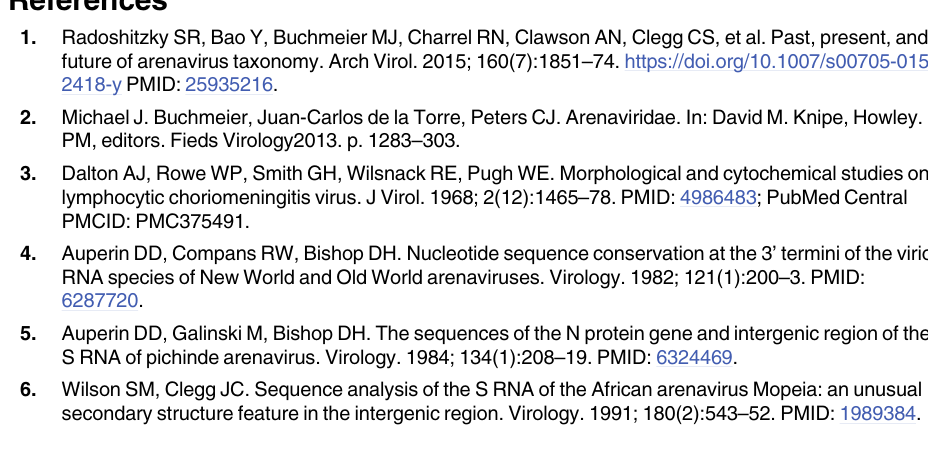
S1 Fig. ELISA seroprevalence assay. A cutoff value of 0.03687 (horizontal line) was deter- mined based on three times the OD values of negative controls. Samples with an OD value greater than the cutoff were deemed positive. S2 Fig. Western blot detection of viral antibodies in rat serum samples. Viral antibody posi- tive (2016YM02, 2016YM41, 2016YM50, and 2015YM52) or negative (2016YM49 and 2013LX05) rodent serum samples were identified by ELISA, and tested against the viral NP by western blot. Human coronavirus (HCoV NL63) His-tagged NP were used as controls. Lanes: 1 and 2, negative control; lanes 3–6, ELISA positive sera (2016YM02, 2016YM41, 2016YM50, and 2016YM52); lanes 7, anti-His antibody. S1 Table. Mammarenavirus sero-detection results for small mammals collected in Yunnan